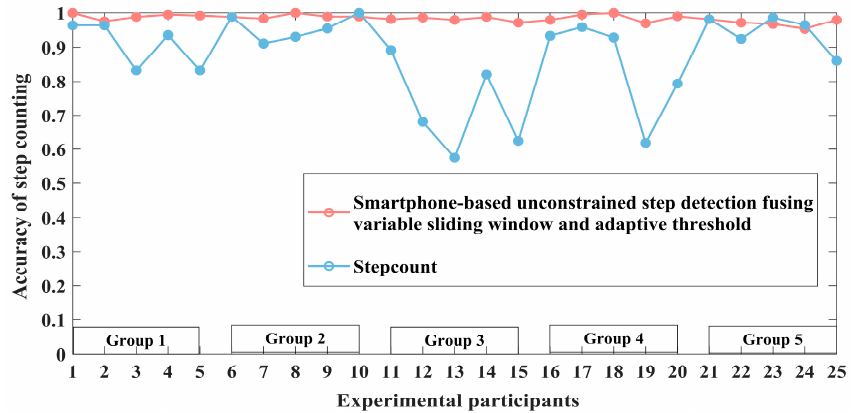
Figure 15. Step counting accuracy in unconstrained state.